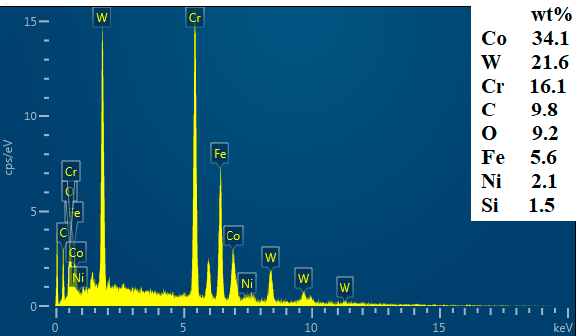
Figure 10. Scanning diffraction pattern of EDS surface after Co-Cr-30%WC wear. Table 3. EDS point analysis of the worn surface of Co-Cr-30%WC cladding layer. Point